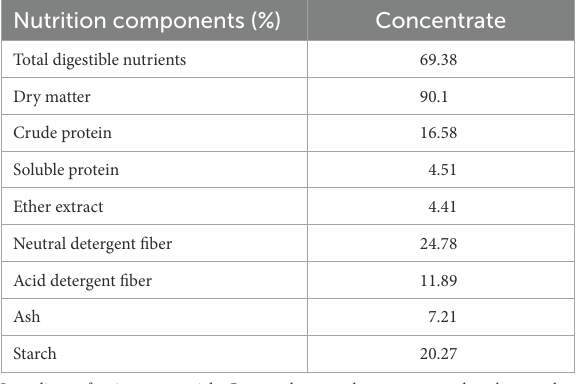
TABLE 2 Analysis of nutritional components of the